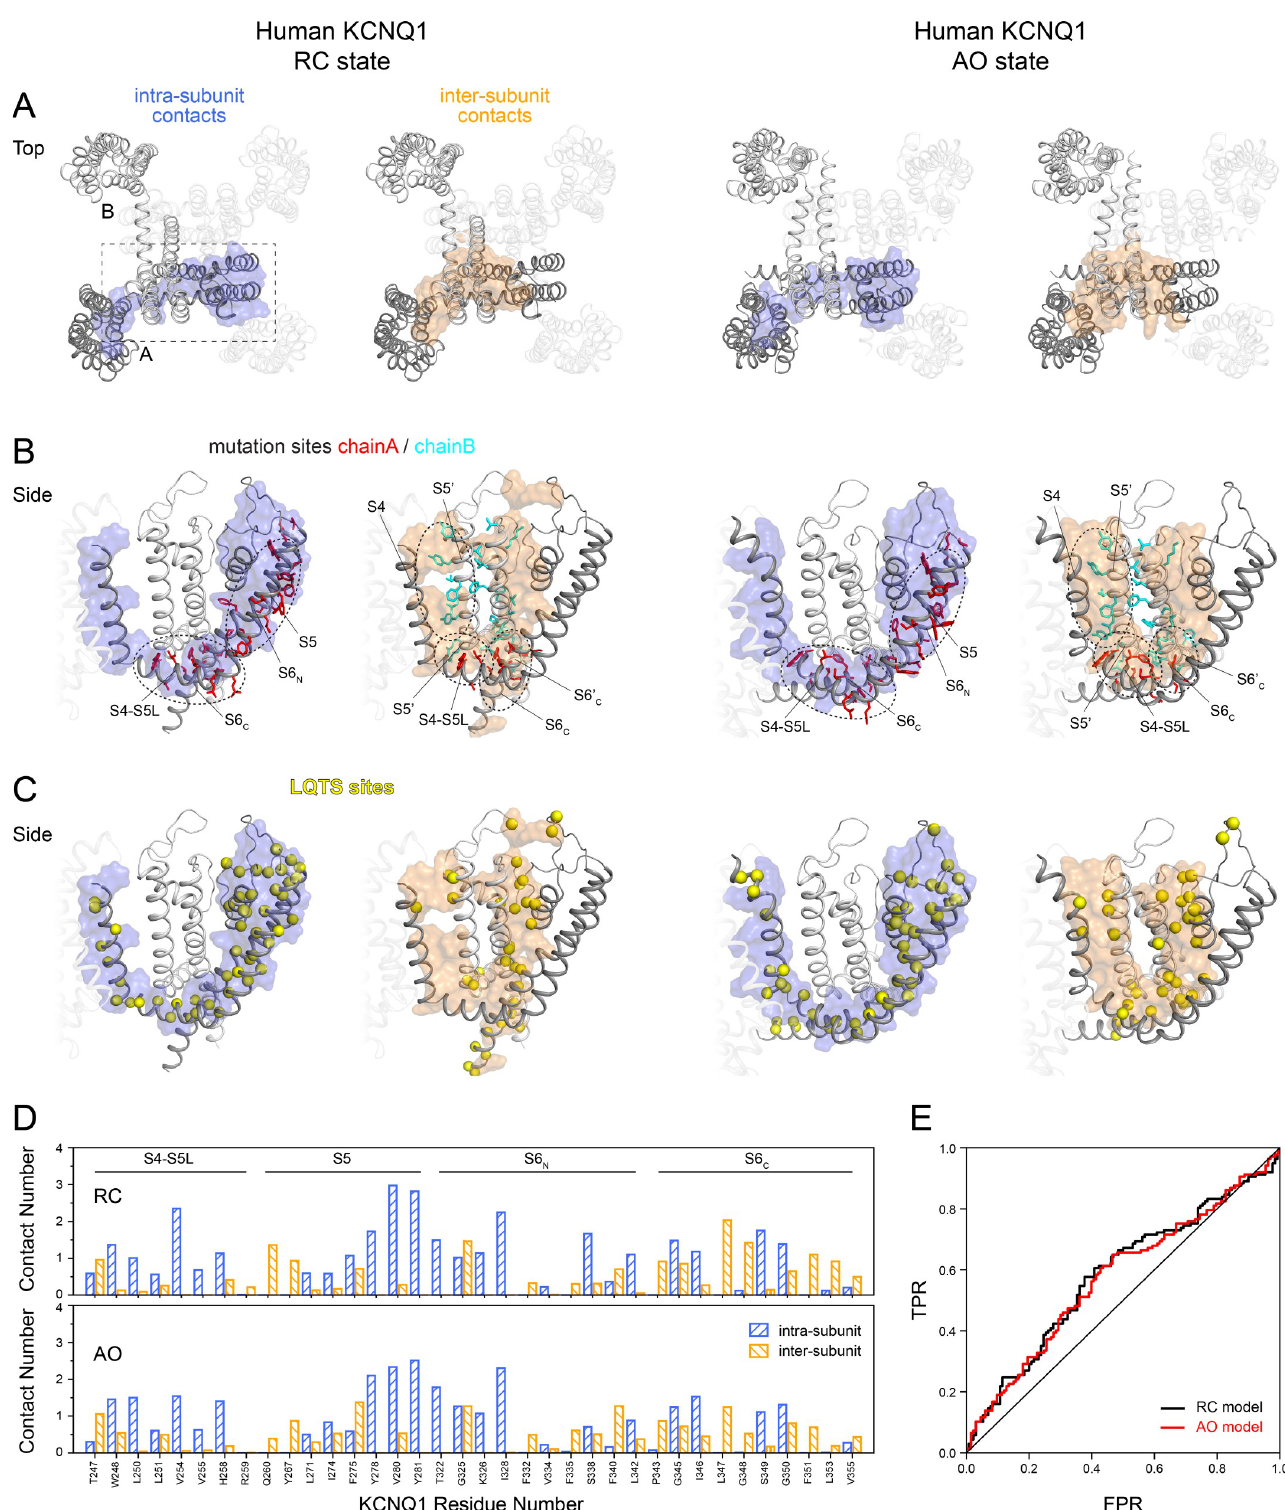
Fig 5. High impact mutations and LQTS sites fall within intra- and inter-subunit contact regions in KCNQ1 channel models. ( A ) Extracellular view of the KCNQ1 RC and AO models. For clarity, only two neighboring subunits are displayed while the other two chains are transparent. Residues in S4 to S6 that make contacts within the same subunit or with residues in the neighboring subunit are shown as surface representation and are colored light blue or orange,